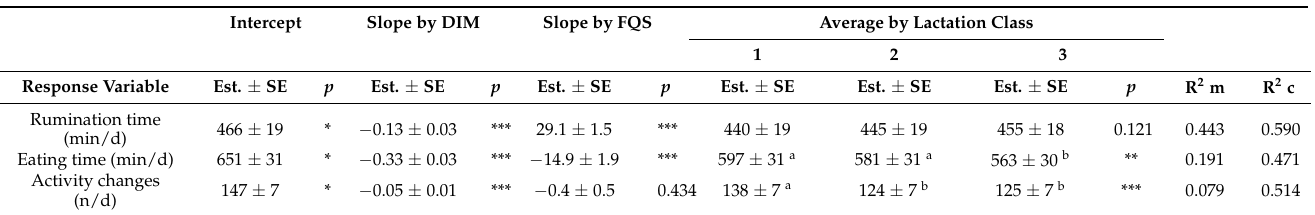
Table 5. Influence of days in milk (DIM), feed quality score (FQS) and lactation class on chewing behavior traits (N observations = 534, N cows = 102, N farms = 2).